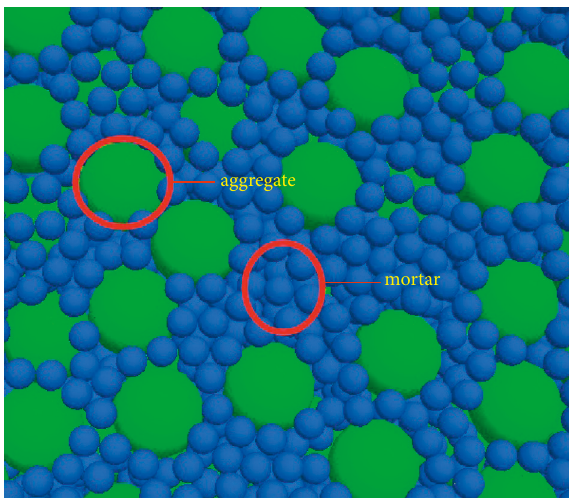
Figure 6: Schematic diagram of particles